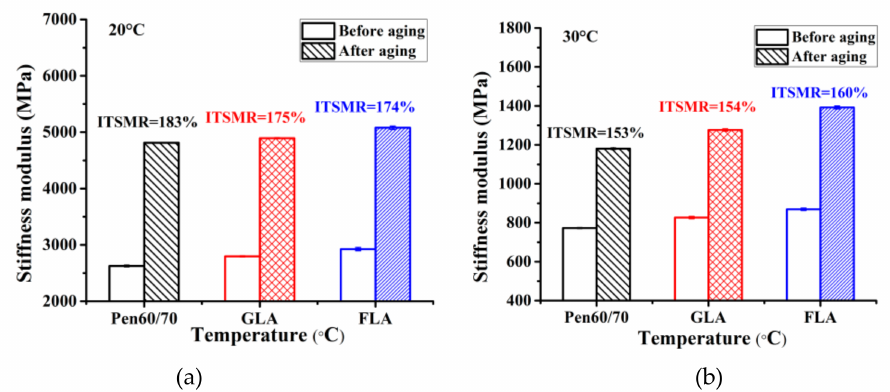
Figure 14. Indirect tensile sti ff ness modulus (ITSM) test results before and after aging: ( a ) 20 ◦ C and ( b ) 30 ◦